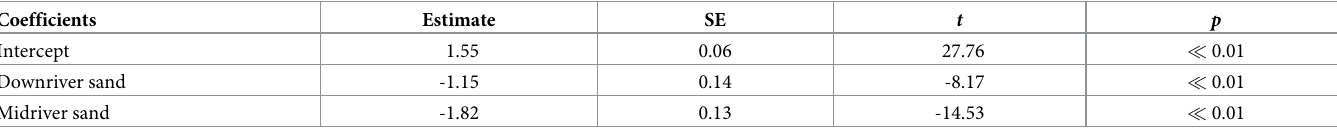
Table 6. Summary of GLM for model g 7 predicting plant biomass, including parameter estimates, standard errors, z values and p values. The intercept represents downriver seagrass. Model g 7 explained 16.5% of the null deviance.